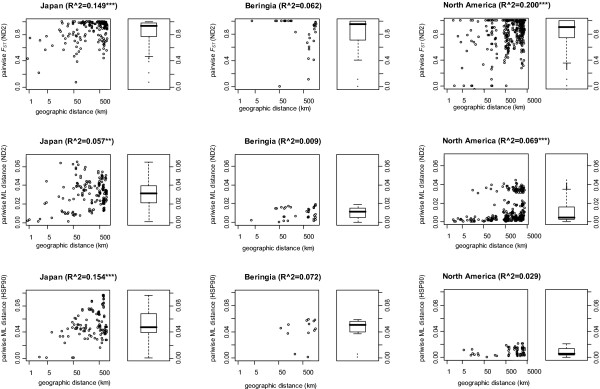
Summaries of relative and absolute pairwise population differentiation and their associations with geographic distance in Daphnia rosea. Row one: associations between pairwise FST's (from ND2 sequences) and geographic distances (log); Row two: associations between pairwise ML distances (from ND2 sequences) and geographic distances (log); and Row three: the associations between pairwise ML distances (from HSP90 sequences) and geographic distances (log). Population-level information for HSP90 FST estimates was unavailable. Boxplot summaries of the pairwise genetic comparisons are shown to the right of each scatterplot. Regression coefficients are given above each scatterplot (*** – P < 0.001; ** – P < 0.01). The first two columns are from presumed glacial refugial regions of Daphnia rosea and the last column is from glaciated North America.